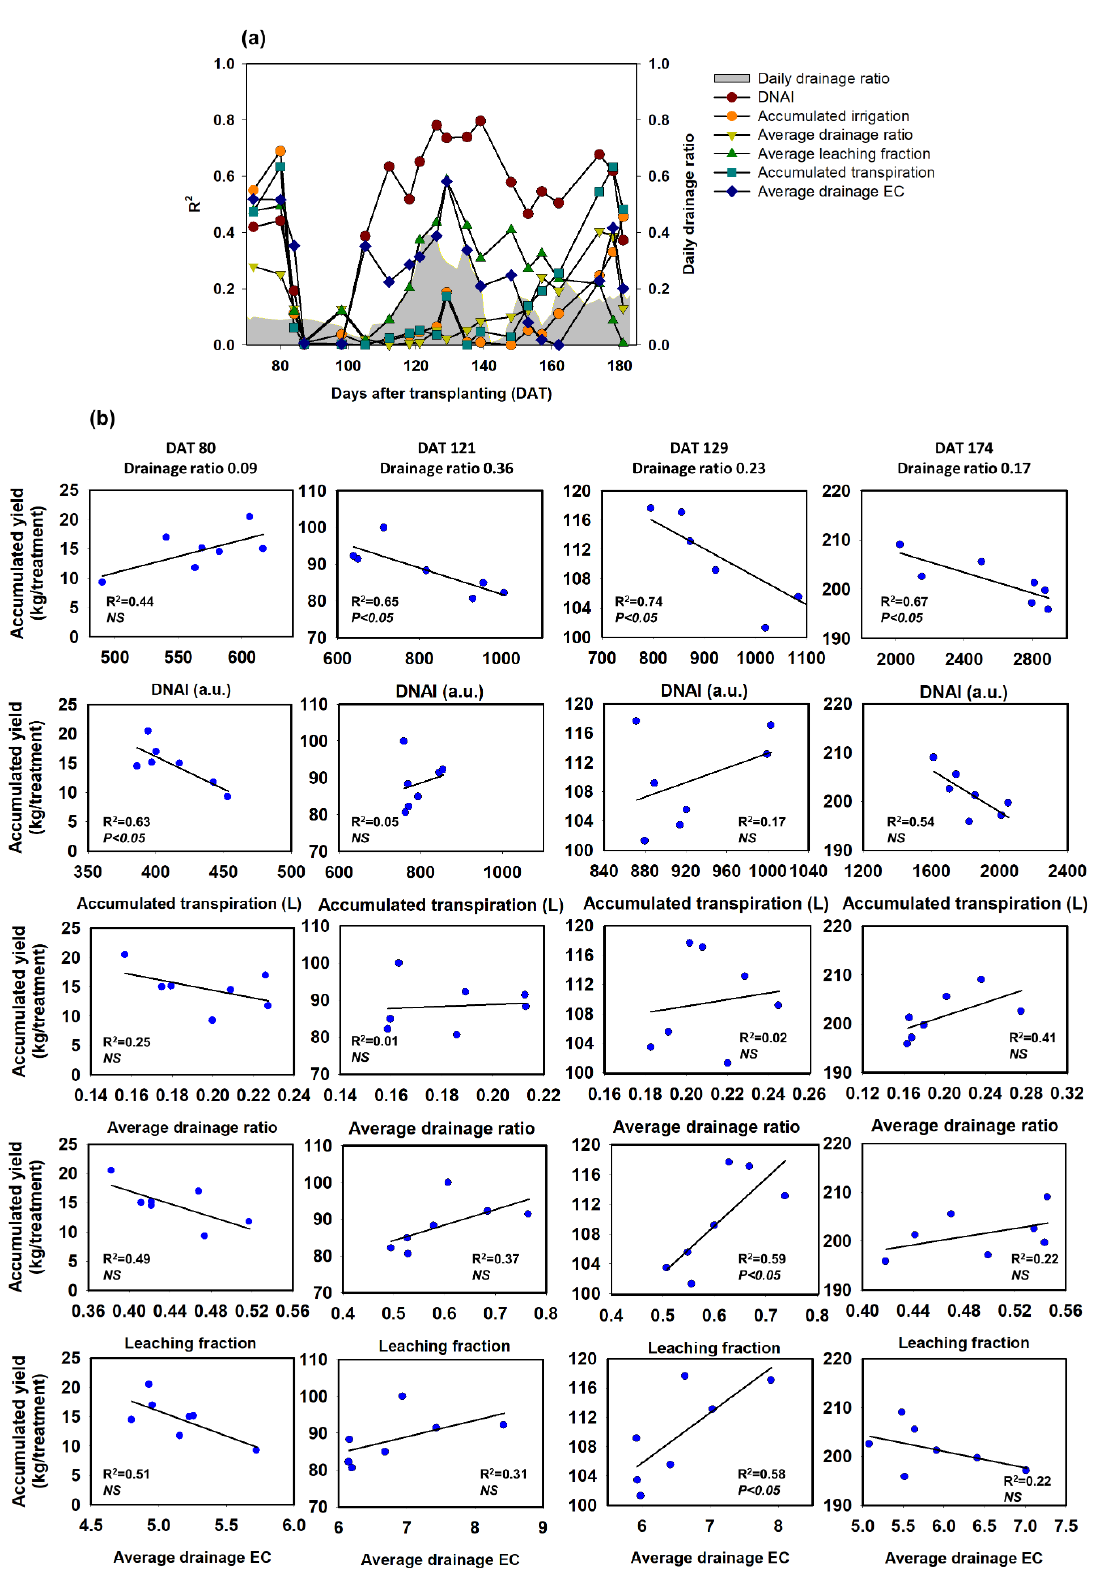
Figure 6. Changes in R 2 values between accumulated fruit yield and indicators in water and nutrient management, and DNAI during the period of the DNAI estimation experiment ( a ). Comparison of representative correlation between measured indicators in water and nutrient management, DNAI, and accumulated fruit yield ( b ).